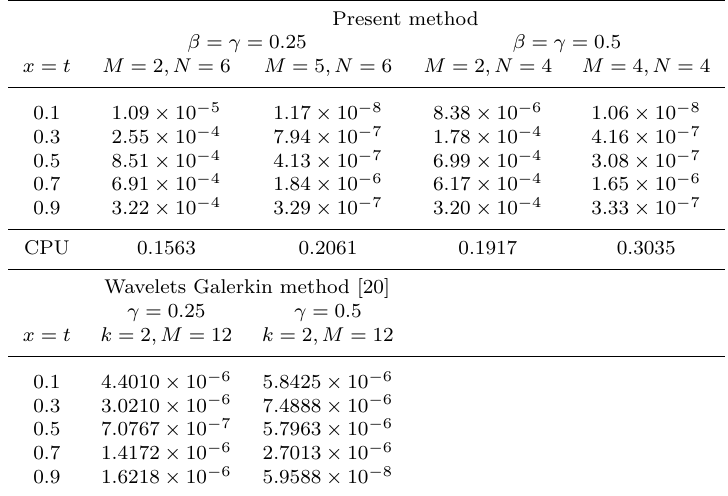
Table 7. Comparison of the absolute errors for different values of M,N,β,γ with method in [20] on the interval [0 , 1] × [0 , 1] for Example 6. Present method β = γ = 0 .